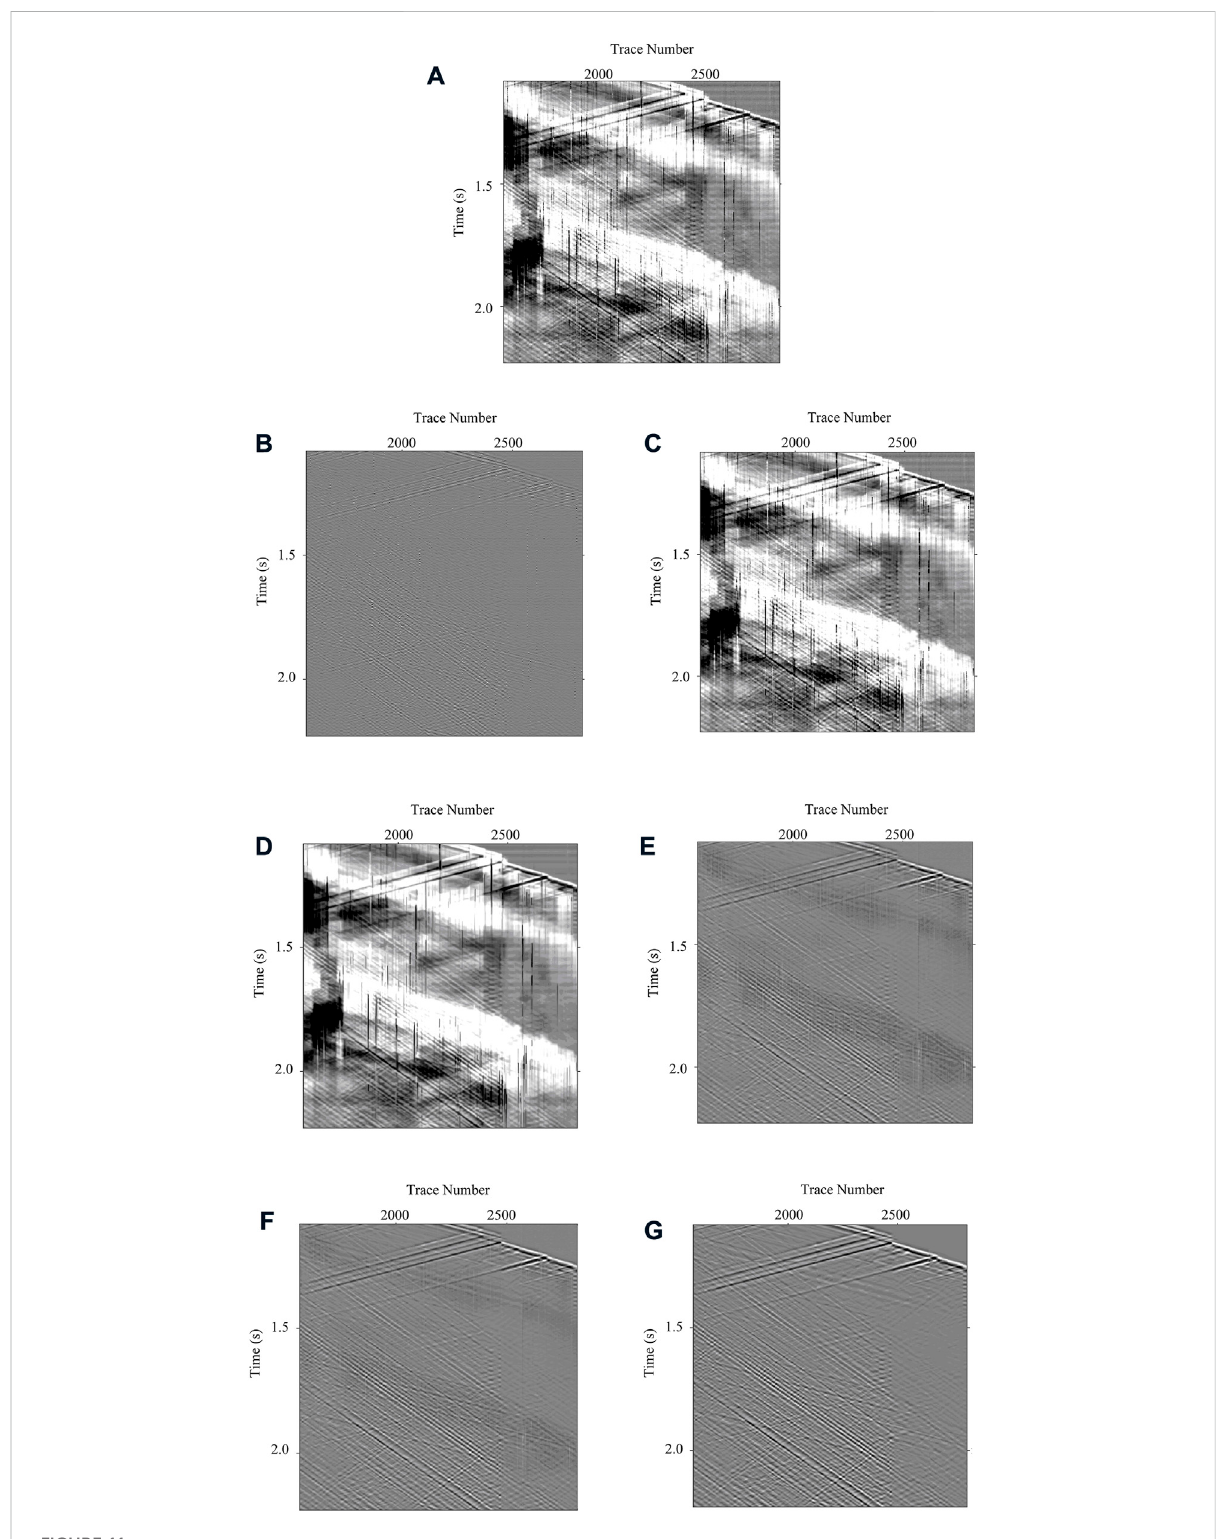
FIGURE 11 Local enlargements for the denoising results of different methods. (A) Local enlargements of the fi eld noisy DAS-VSP data. (B – G) Local enlargements of denoising results by utilizing Band-pass fi ltering, Wavelet transform fi ltering, WNNM, DnCNN, U-Net, and MSI-Net,